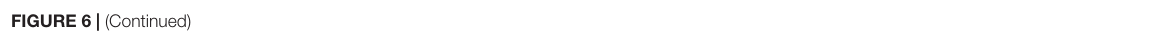
FIGURE 7 | Effect of CRISPR-based regulated expression of TPM1 on F-actin organization, continuity of cell–cell junctions, and proangiogenic prosperities of TNF α -activated pHCAECs. (A) Representative confocal micrographs of fluorescently stained F-actin and VE-cadherin. Triple fluorescent staining for VE-cadherin (red), F-actin (green), and DNA (blue) was performed after fixation of pHCAECs nucleofected with CRISPR control (left panel), CRISPR TPM1 activation (middle panel), or CRISPR TPM1 -knockout systems (right panel). TNF α 100 ng/ml refers to cells treated with rh TNF α (right panel). (B) Representative intravital correlative holotomographic and fluorescence micrographs of pHCAECs nucleofected with the CRISPR TPM1 -knockout system. Actin-GFP (red) and talin-RFP (green) were expressed using baculoviruses. TNF α 100 ng/ml to cells treated with rh TNF α . (C) Representative bright-field micrographs presenting tube formation by pHCAECs nucleofected with CRISPR control (left panel), CRISPR TPM1 activation (middle panel), and CRISPR TPM1 -knockout systems cultured on Matrigel. The tubular structures were stained with crystal violet after 6 h from seeding. TNF α 100 ng/ml refers to cells treated with rh TNF α . (D) Number of tubes per microscopic field formed by TNF α -activated pHCAECs with CRISPR-based regulated expression of TPM1 . ** refers to p < 0.01, as determined by the Kruskal–Wallis test.